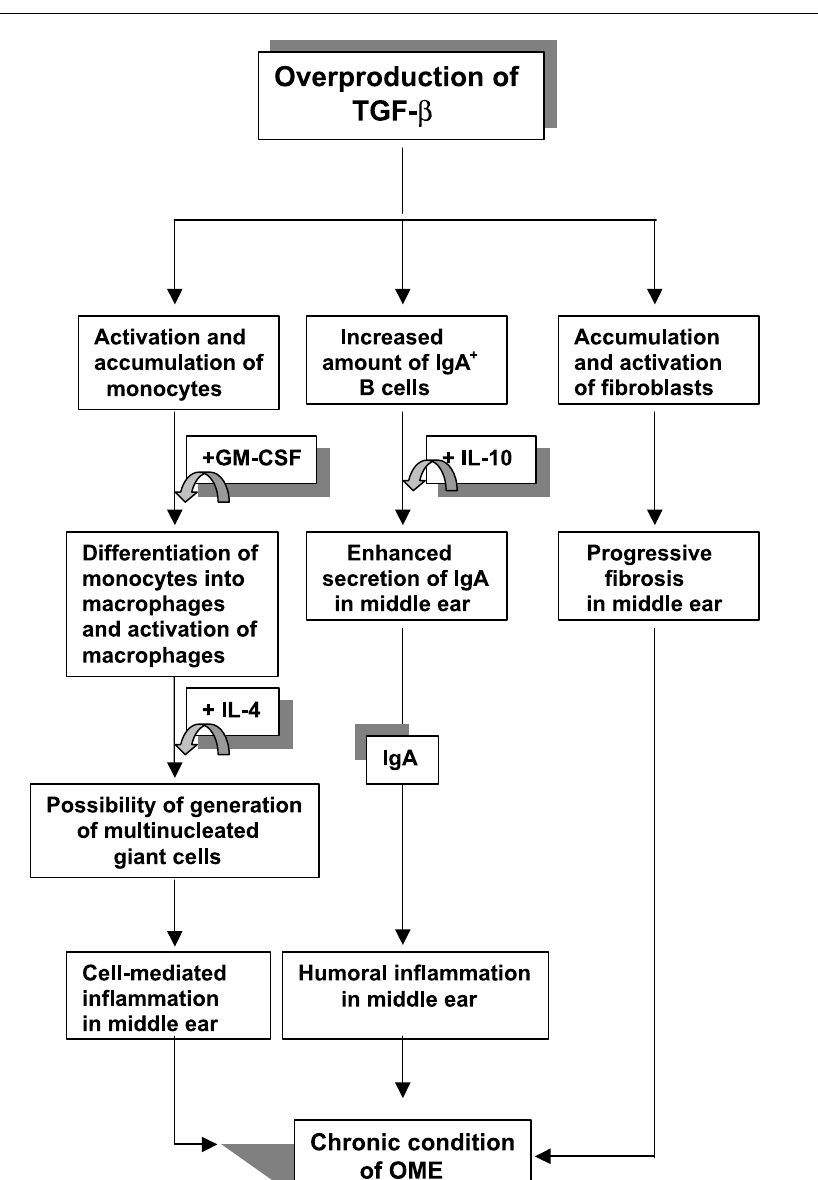
FIG. 5. Consequences of the overproduction of TGF- b in the course of the middle ear